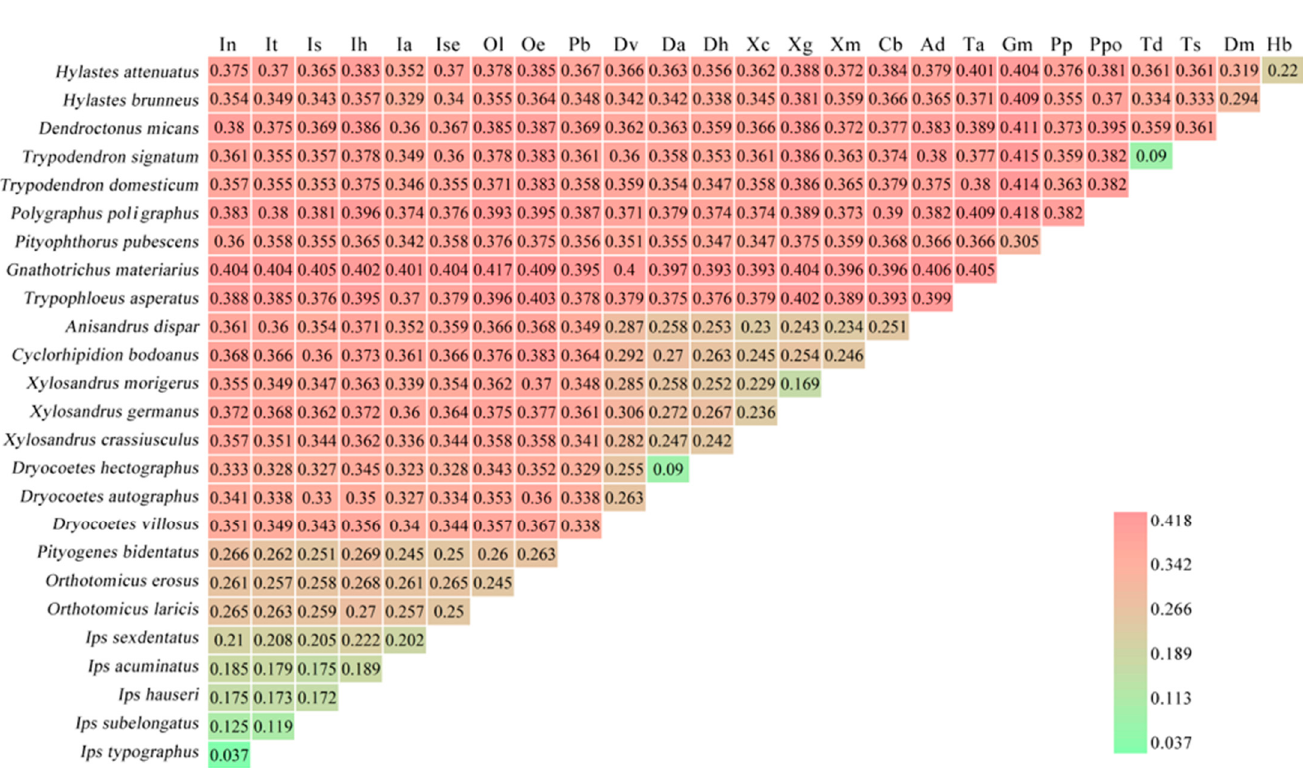
7 of 12 Figure 3. Phylogenetic tree inferred from mitogenomes of the subfamily Scolytinae using Bayesian inference method ( A ) and maximum likelihood method ( B ). Values at nodes indicate Bayesian posterior probabilities and bootstrap values for the BI and ML trees, respectively. Clades with different colors indicate different tribe. 3.5. Analysis of the Genetic Distance and the Evolutionary Rate Genetic distances between sequenced bark beetles based on the whole mitogenome supported their phylogenetic relationships. The distances between species within a genus were shorter than the distances between genera. The shortest distance, and thus the closest genetic relationship, was between I. typographus and I. nitidus (0.037), whereas the greatest distance was between P. poligraphus and G. materiarius (0.418) (Figure 4). Among the bark beetles of the Scolytinae, most of the genetic distances between species were greater than 0.1, except for the distances between Dryocoetes hectographus and Dryocoetes autographus , Trypodendron signatum (Fabricius, 1792) and Trypodendron domesticum (Linnaeus, 1758), and I. typographus and I. nitidus , suggesting that they are sibling species. The Ka/Ks ratio, a diagnostic statistical method for detecting molecular adaptations,